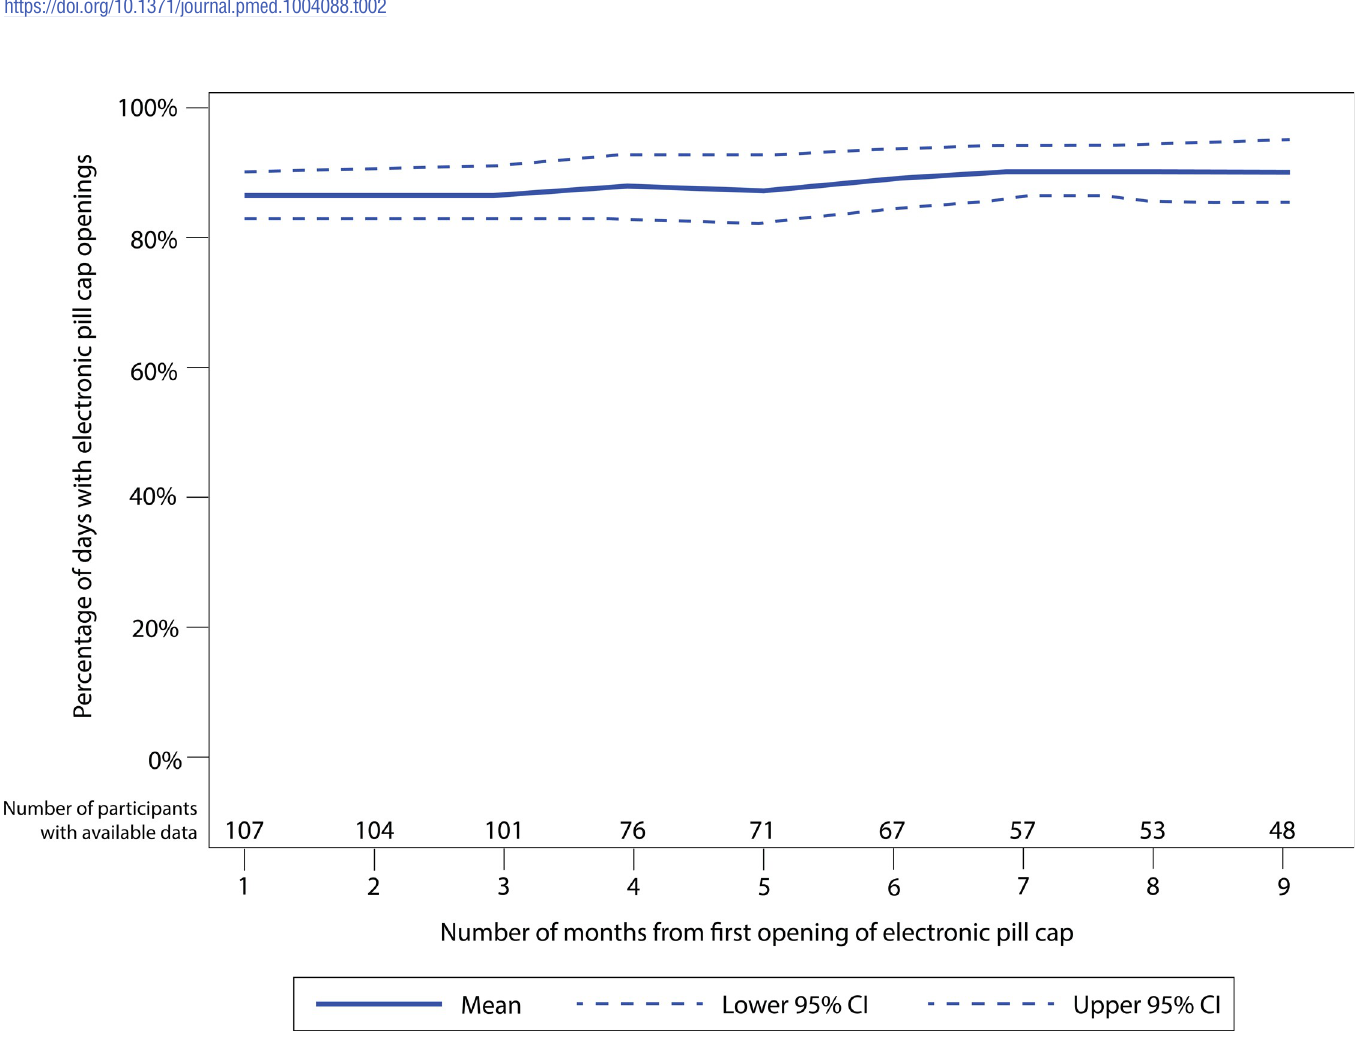
Fig 3. Mean and 95% confidence interval bands for electronic adherence to PrEP during periconception period over